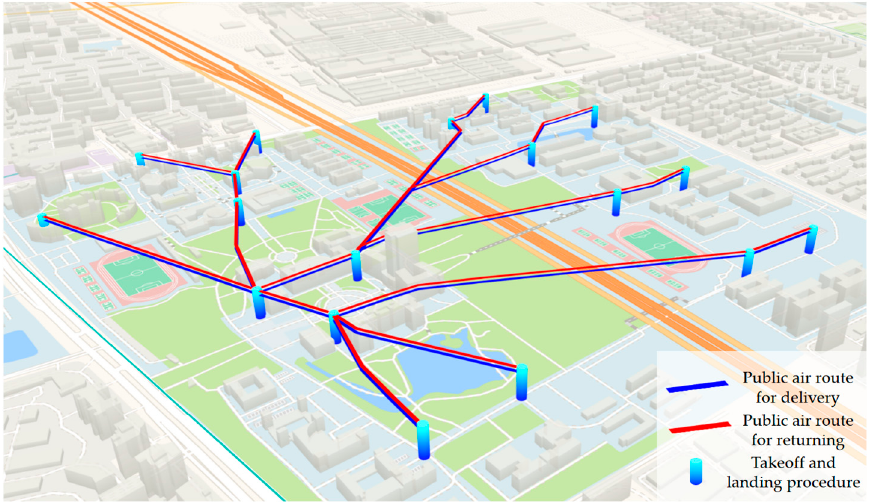
Figure 13. The actual layout of round-trip public air routes.